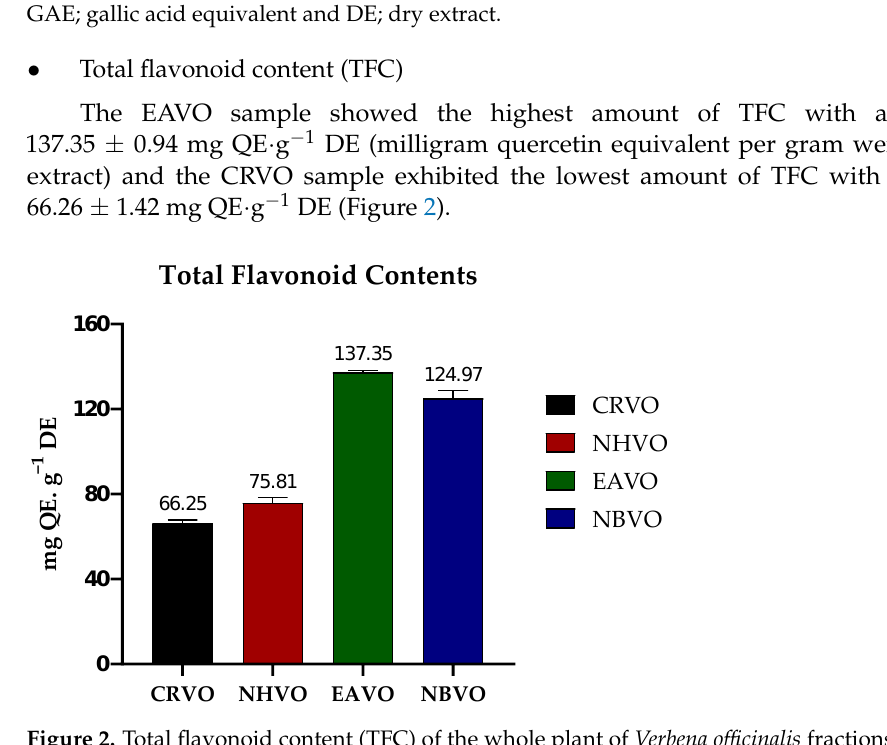
Figure 2. Total flavonoid content (TFC) of the whole plant of Verbena officinalis fractions (All experi- ments were performed in triplicates and the error bar represents standard deviation). CRVO; crude methanol fraction, NHVO; n -hexane fraction, EAVO; ethyl acetate fraction, NBVO; n -butanol fraction, QE; quercetin equivalent and DE; dry extract.